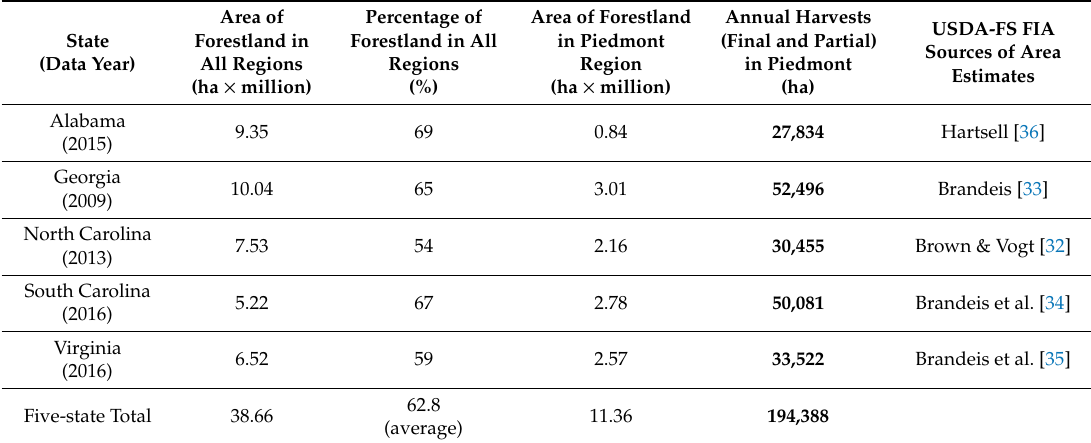
Table 2. Areas of forestland, forestland in Piedmont, and Piedmont final and partial (not thinning) harvests (bold) as estimated from USDA Forest Service Forest Inventory Analyses